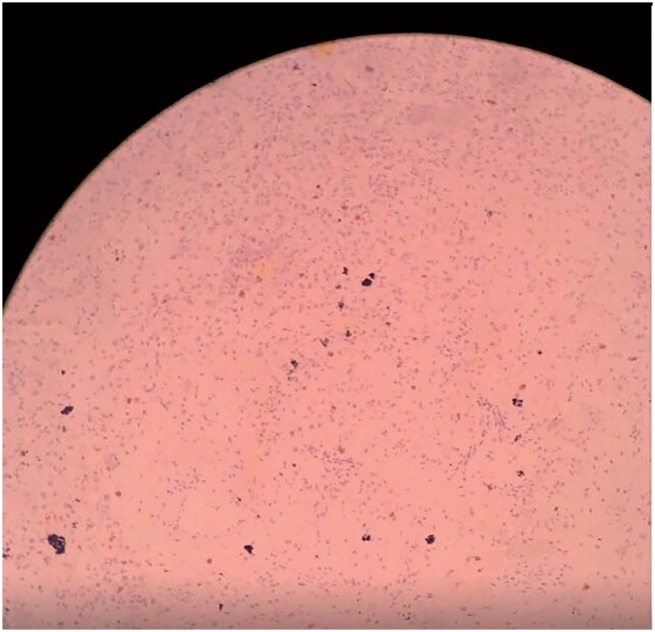
Ki-67 antibody (4x).